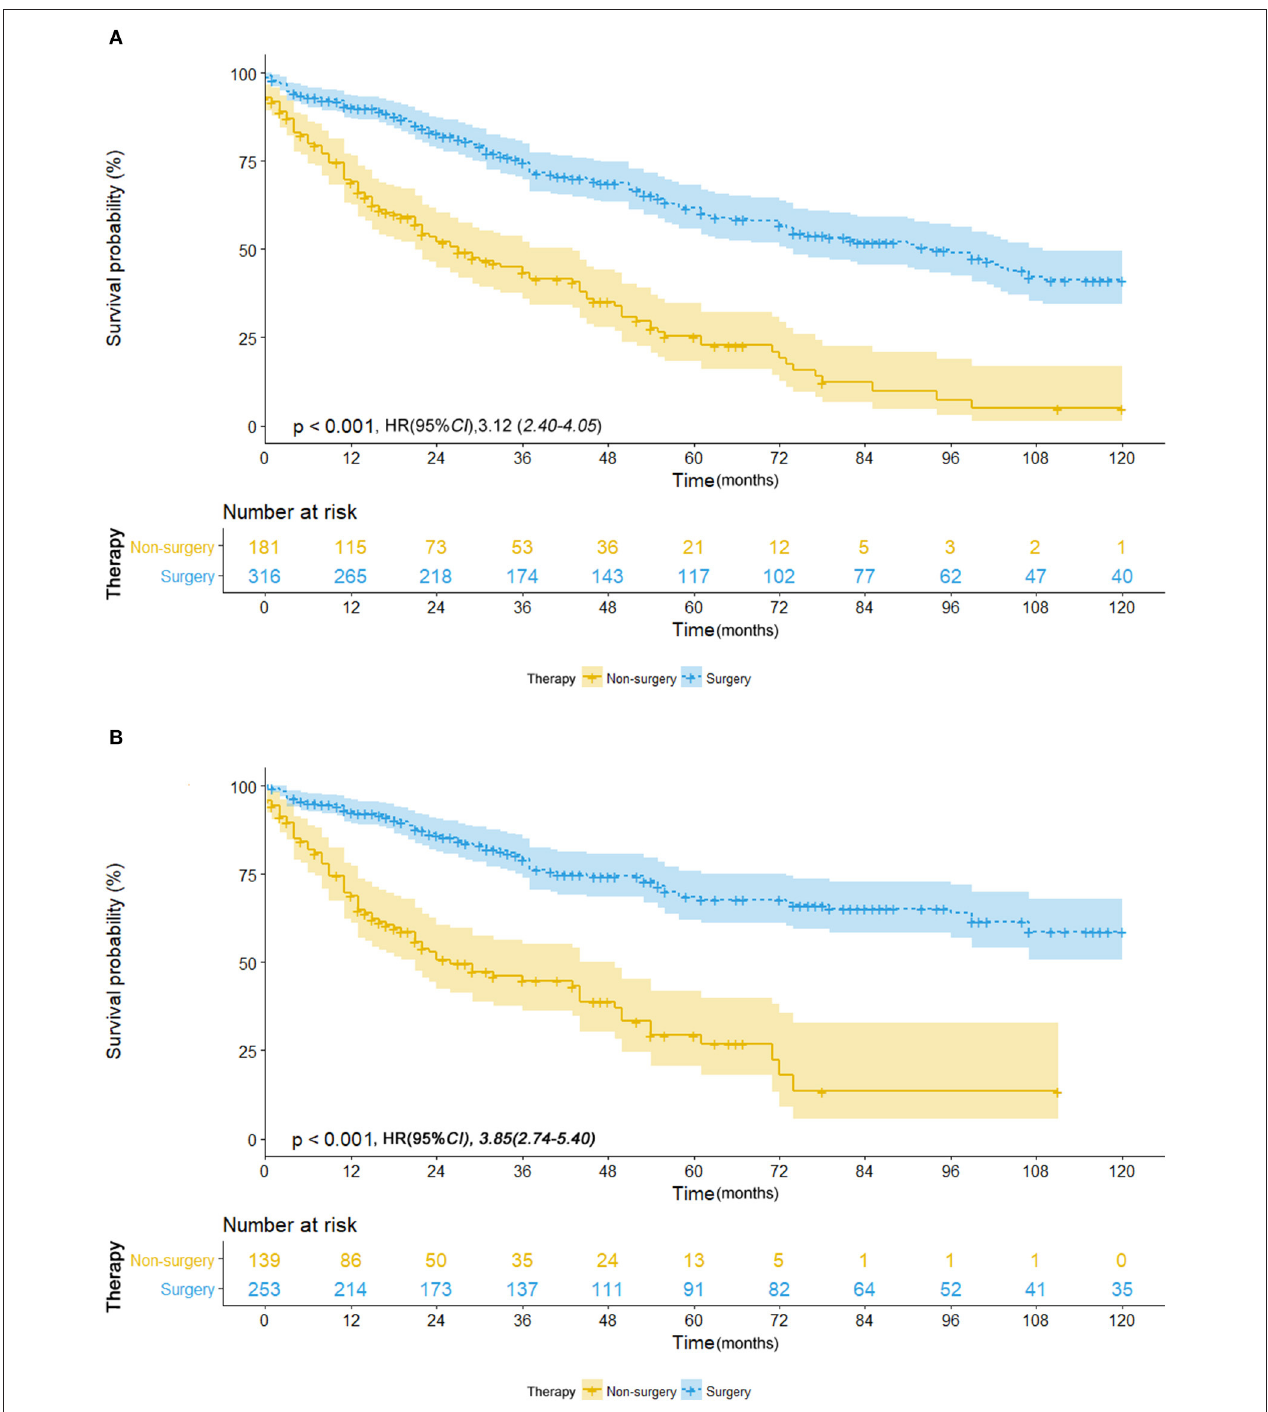
FIGURE 5 | (A) Overall survival in patients with NSCLC ≤ 8mm who received surgical treatment (blue line) vs. non-surgical treatment (yellow line) after propensity score matching. (B) Cancer-specific survival in patients with NSCLC ≤ 8mm who received surgical treatment (blue line) vs. non-surgical treatment (yellow line) after propensity score